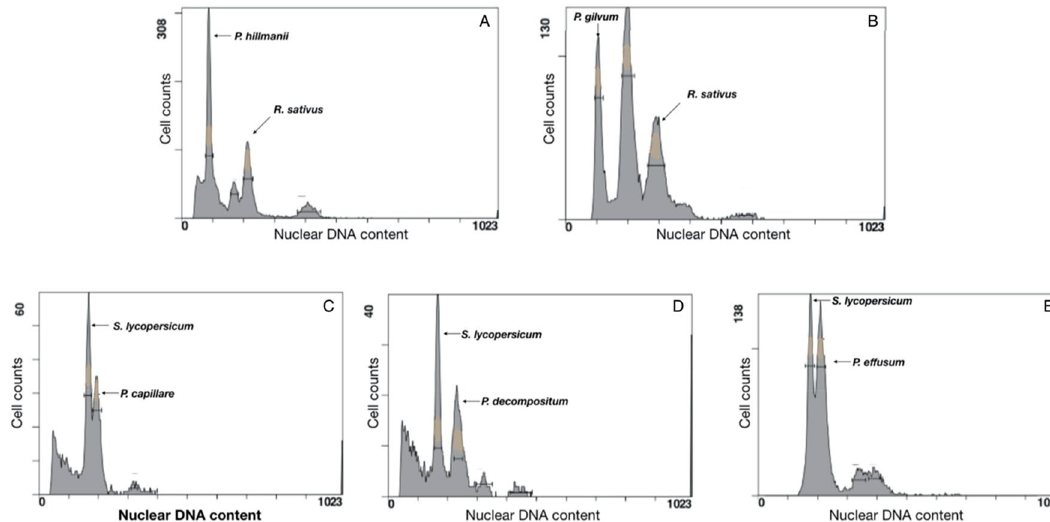
Figure 4. Flow cytometry histograms of Panicum hillmanii ( A ) and P. gilvum ( B ) using radish ( Raphanus sativus , 1C = 0.55 pg), together with P. capillare ( C ), P. decompositum ( D ) and P. effusum ( E ) using tomato ( Solanum lycopersicum, 1C = 1.06 pg), as an internal reference.